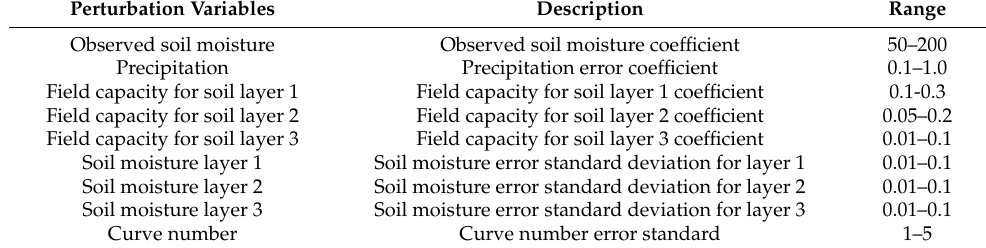
Table A3. Name, description and the range of perturbation defined errors of the EnKF data assimila- tion framework.